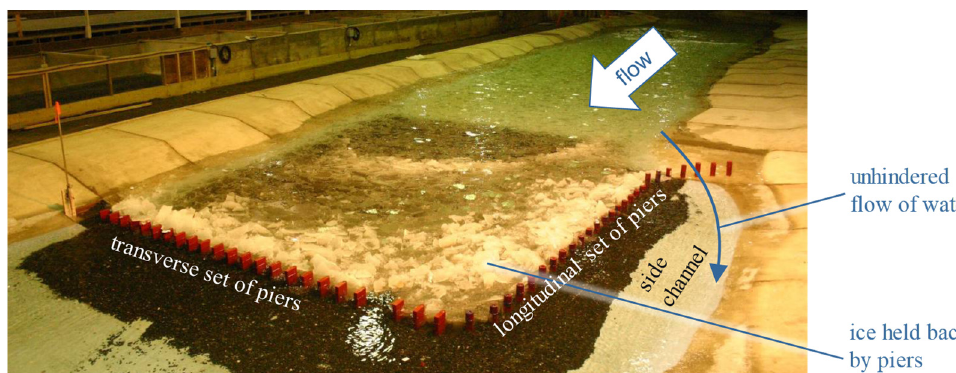
Figure 16. Cross-section of the hanging dam formed at the Wloclawek Reservoir inlet near Plock in February 2021 [29].